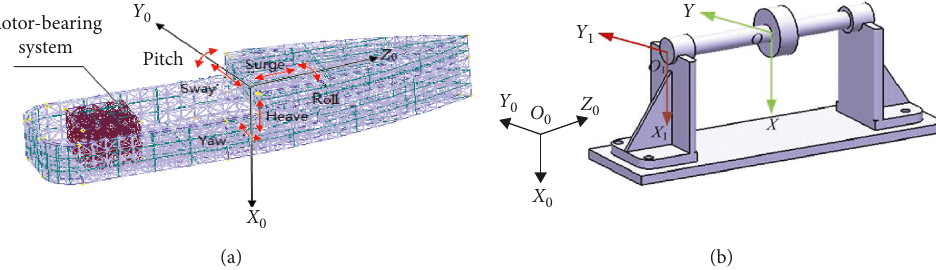
Figure 1: Schematic diagram of transport motion of ship and a marine rotor-bearing system. (a) Transport motion. (b) Rotor-bearing system.